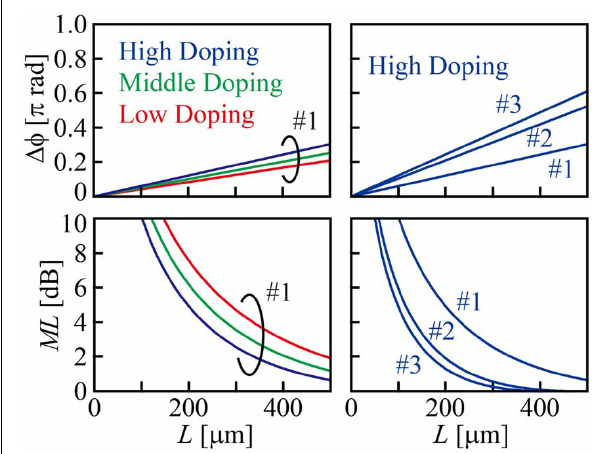
FIGURE 5 | Calculation results of phase shift and modulation loss with phase shifter length for device #1–#3 when ER = 3dB is assumed. Voltage change is set from − 0.625 to −